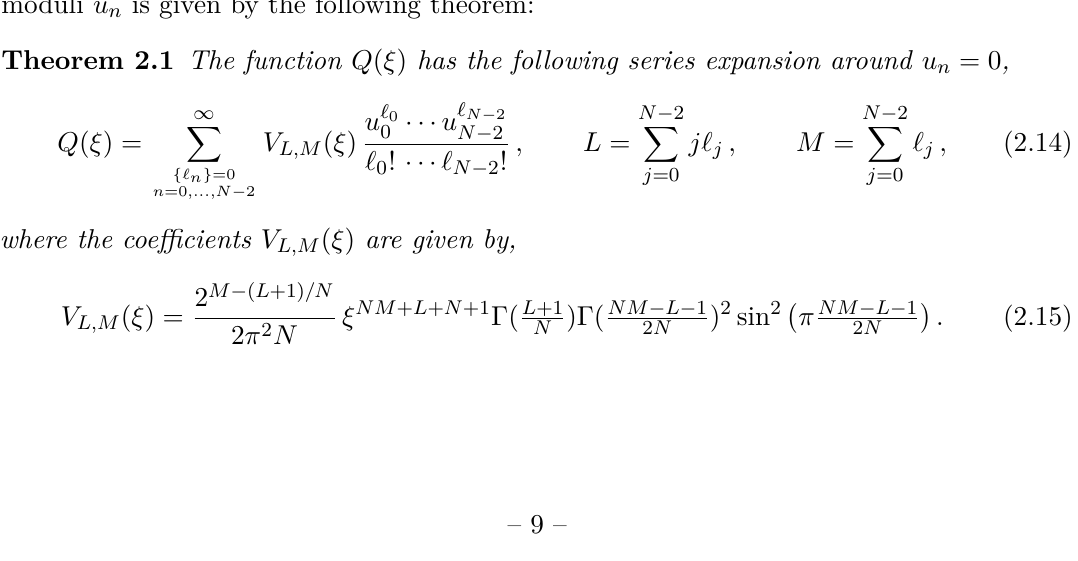
Figure 2. Branch points x = ε n for the Z case N = 3 , for which ε = e 2 πi/ 6 . The branch cuts are denoted by black double lines, while the ˆ A J and B I cycles defined above are shown in blue and red, respectively. The integration paths used to define the function Q ( ξ ) (see (2.13) below) are shown in